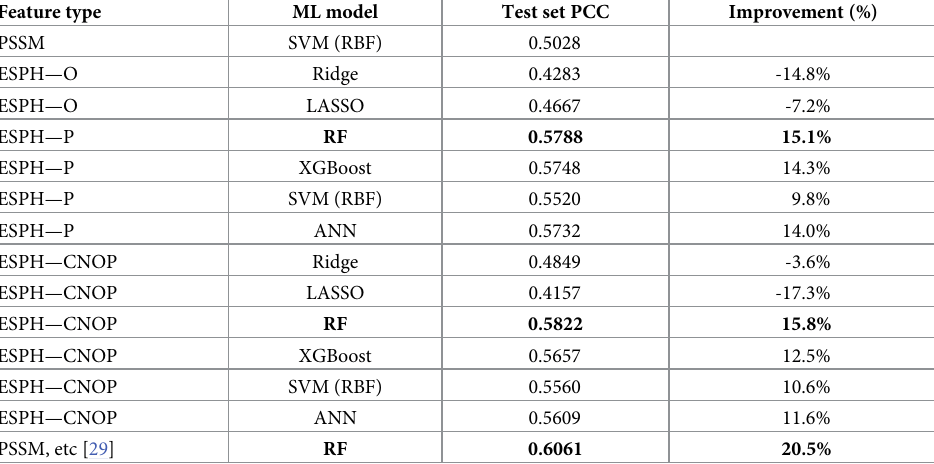
Table 2. Best test set performance for each ML model using the optimal hyperparameter values for dataset and ML model. PSSM stands for Position Specific Scoring Matrix, which is the benchmark performance by Guruge et al.